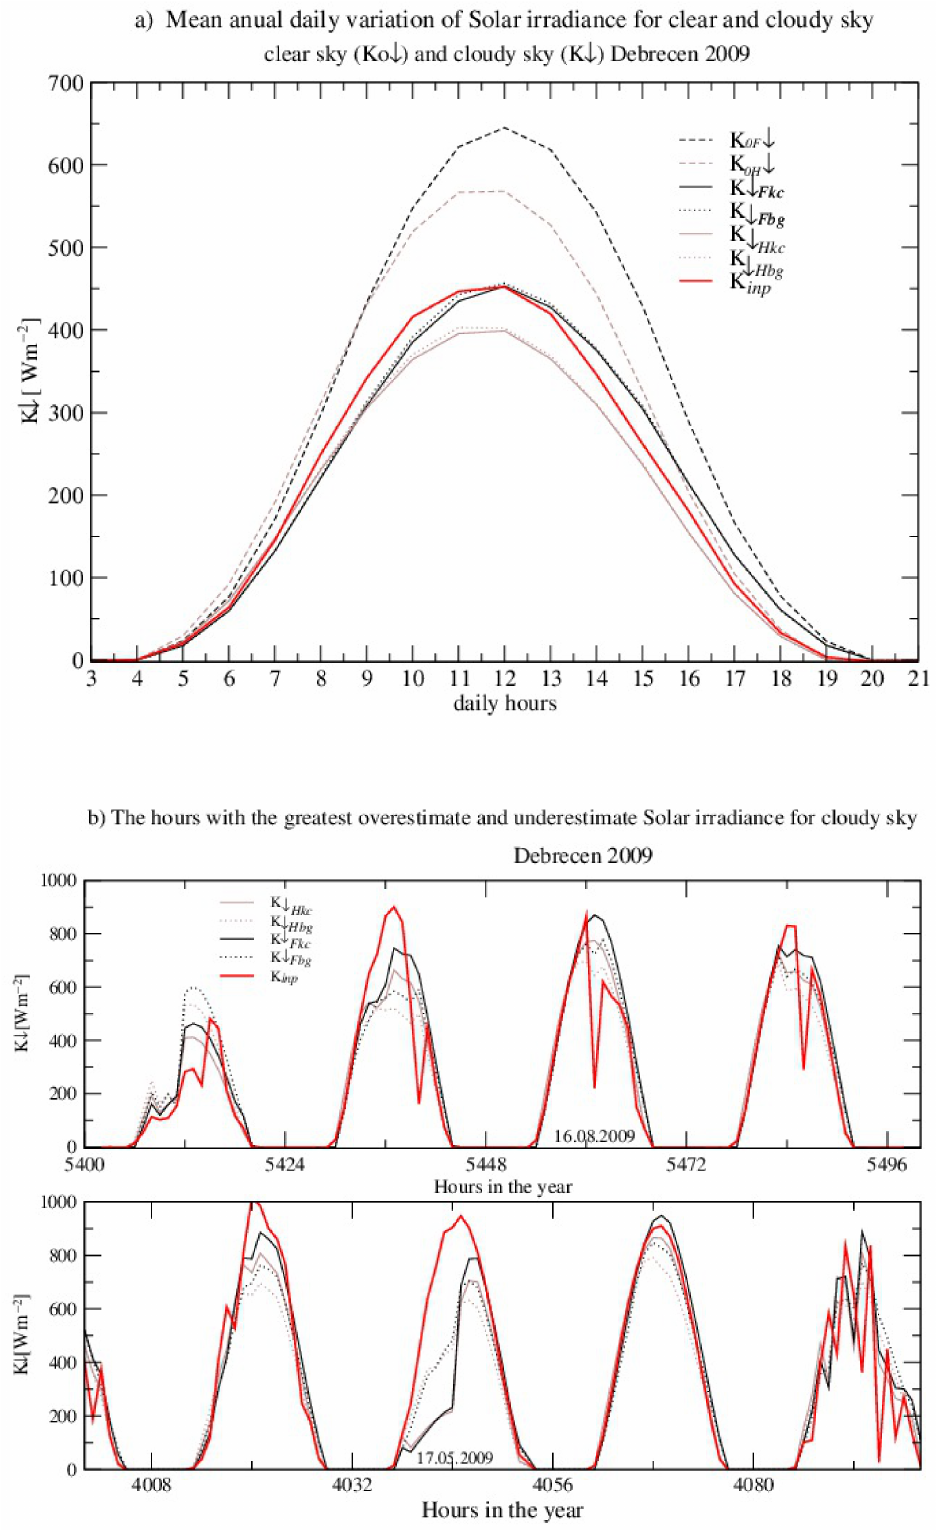
Figure 3. Comparisons between the measurements and four models for the calculation of global solar irradiance can be seen with the ( a ) mean annual daily variations of the global solar irradiance. ( b ) The hours with the greatest